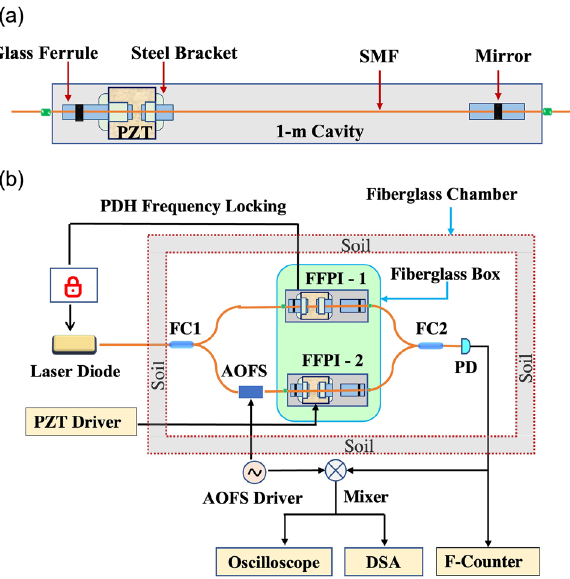
Figure 1. ( a ) A schematic diagram of the FFPIs used in the experiment. ( b ) System layout of the MZ-FP hybrid